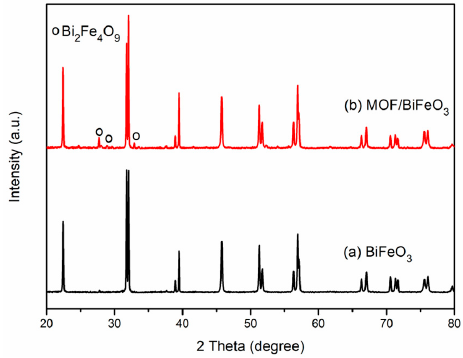
Figure 2. XRD patterns of ( a ) pure BiFeO 3 and ( b ) MOF/BiFeO 3 .